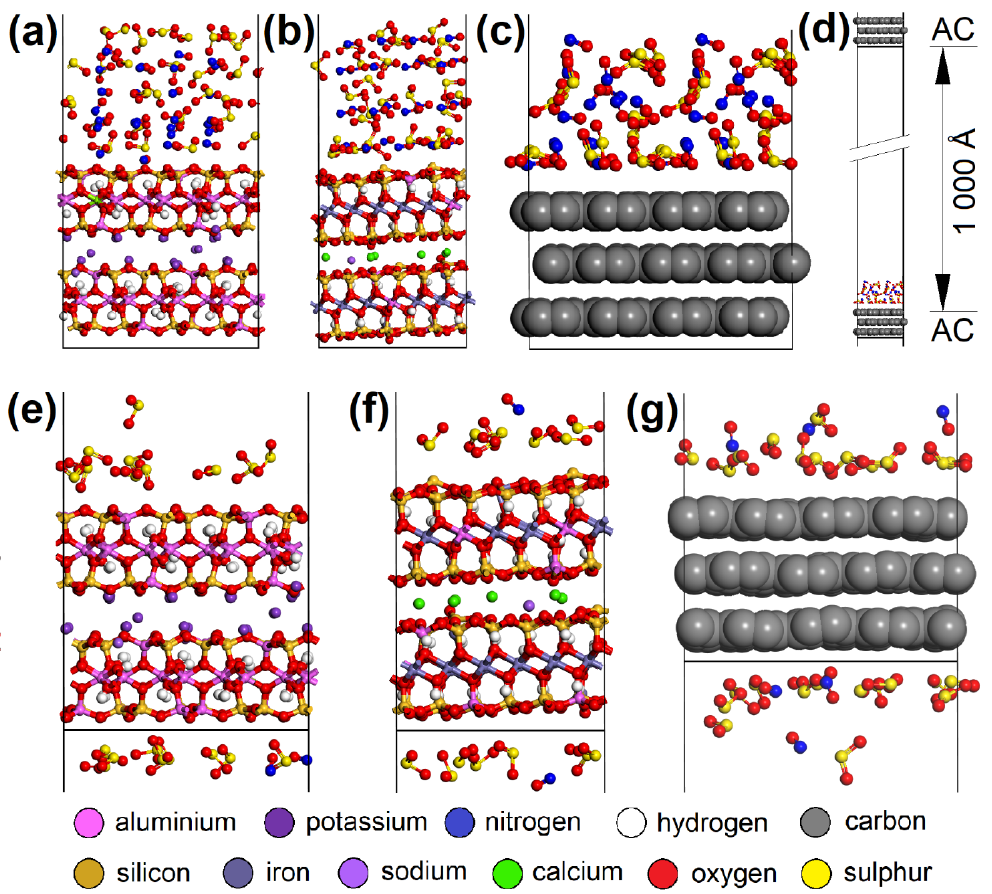
Figure 12. The initial molecular models containing 28 SO 2 and 28 NO molecules on the ( a ) MUS, ( b ) NON, and ( c ) AC surfaces. ( d ) The initial AC cell with EG molecules and the vacuum slab. The models after molecular dynamics showing the preference of SO 2 over NO molecules during the adsorption process on the ( e ) MUS, ( f ) NON, and ( g ) AC surfaces. MUS — muscovite, NON — nontronite, AC — activated carbon; EG — emission gas.